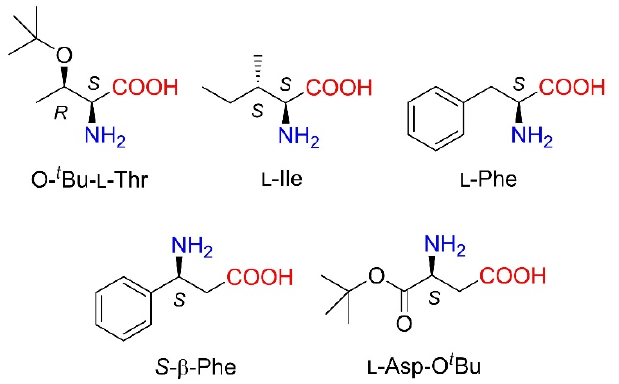
Figure 1. Amino acid organocatalysts found to be highly efficient in Michael additions of carbonyl compounds to N ‐ substituted maleimides.